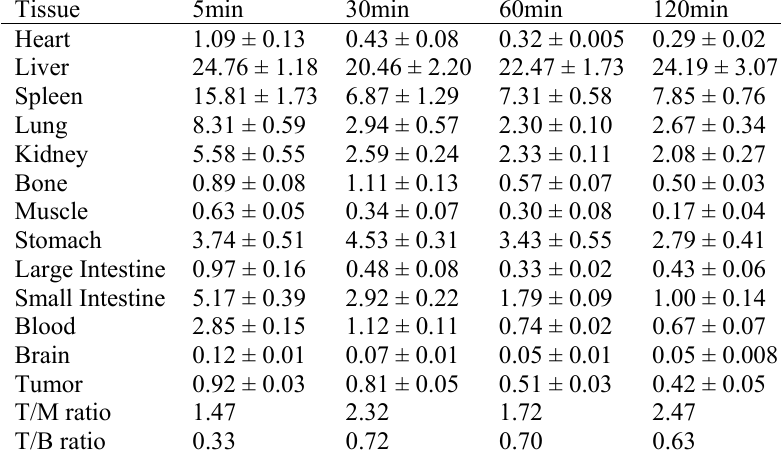
Table 4. Biodistribution of 99m TcN-MAA-ABCPP in mice bearing S 180 tumor (%ID/g) c .